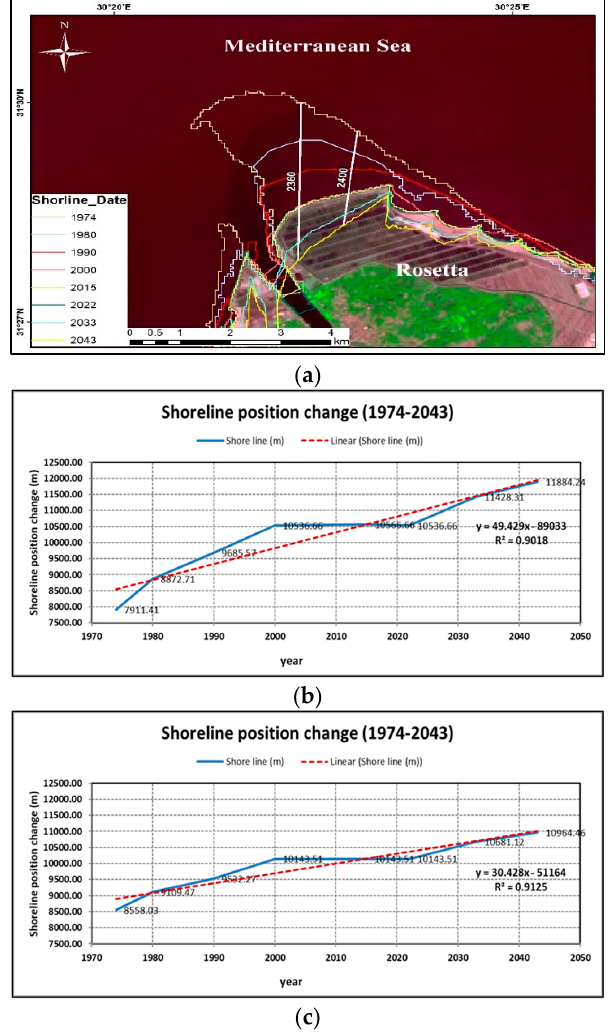
Figure 8. Shoreline changes over time at Rosetta (1974–2043): ( a ) shoreline change at Rosetta, ( b ) time series of changing the shoreline position at transect 2360, ( c ) time series of changing the shoreline position at transect 2400.